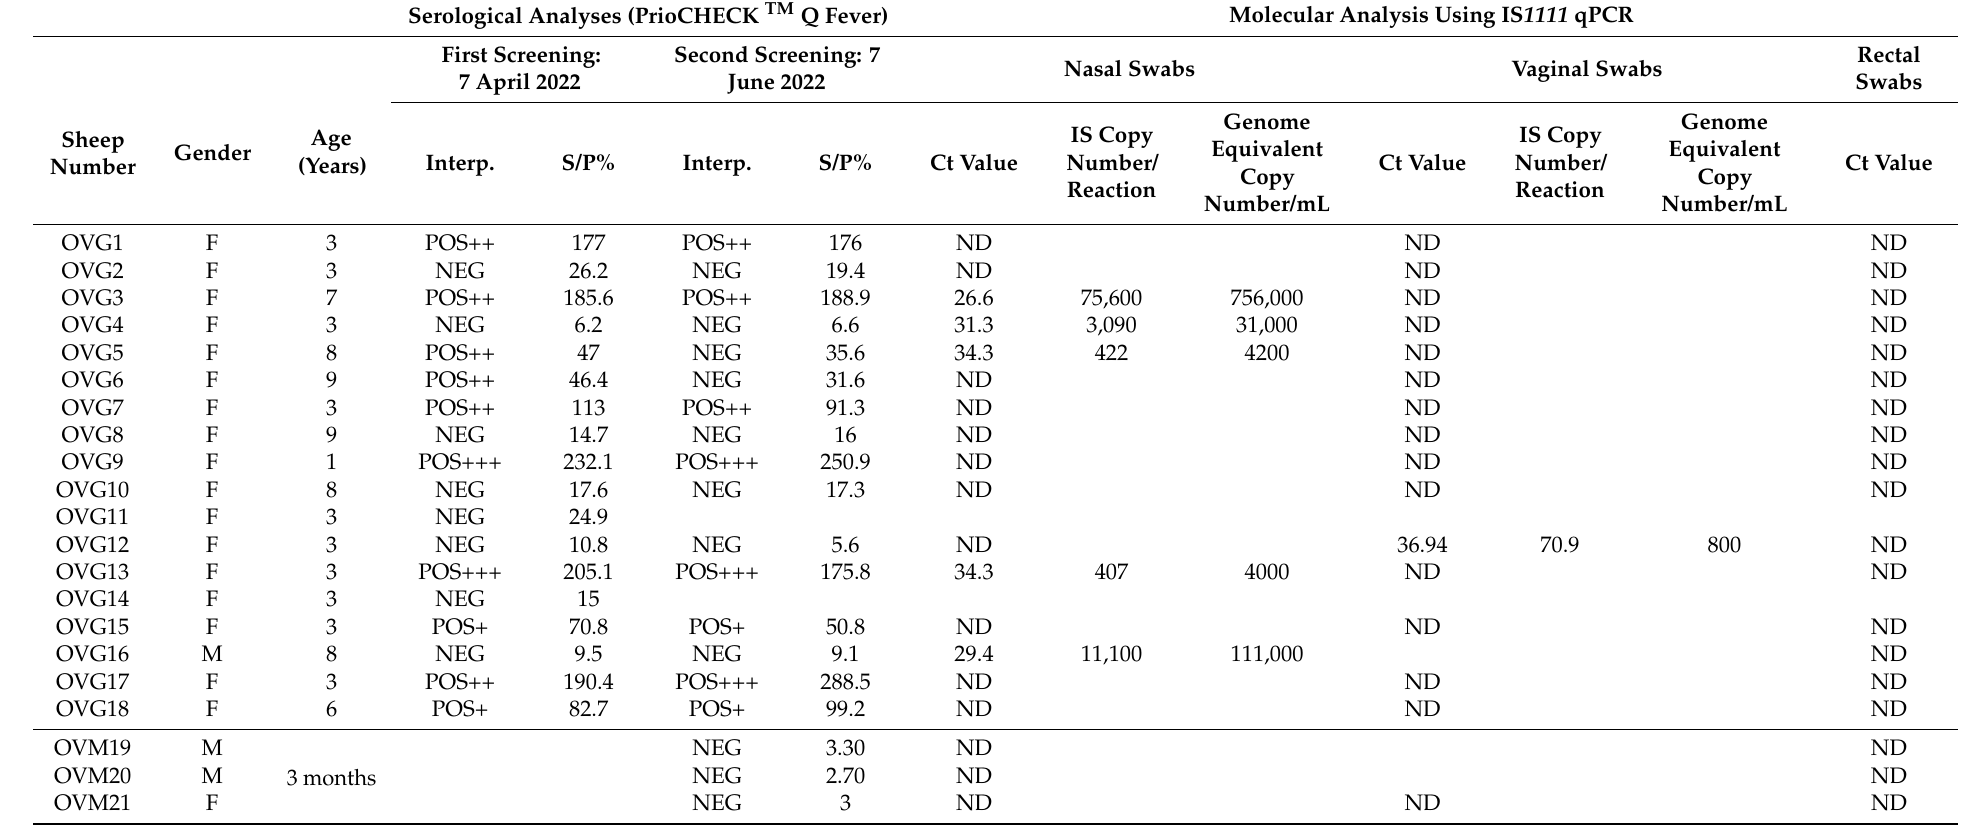
Table 3. Anti- C. burnetii antibodies and real-time quantitative PCR results on sheep